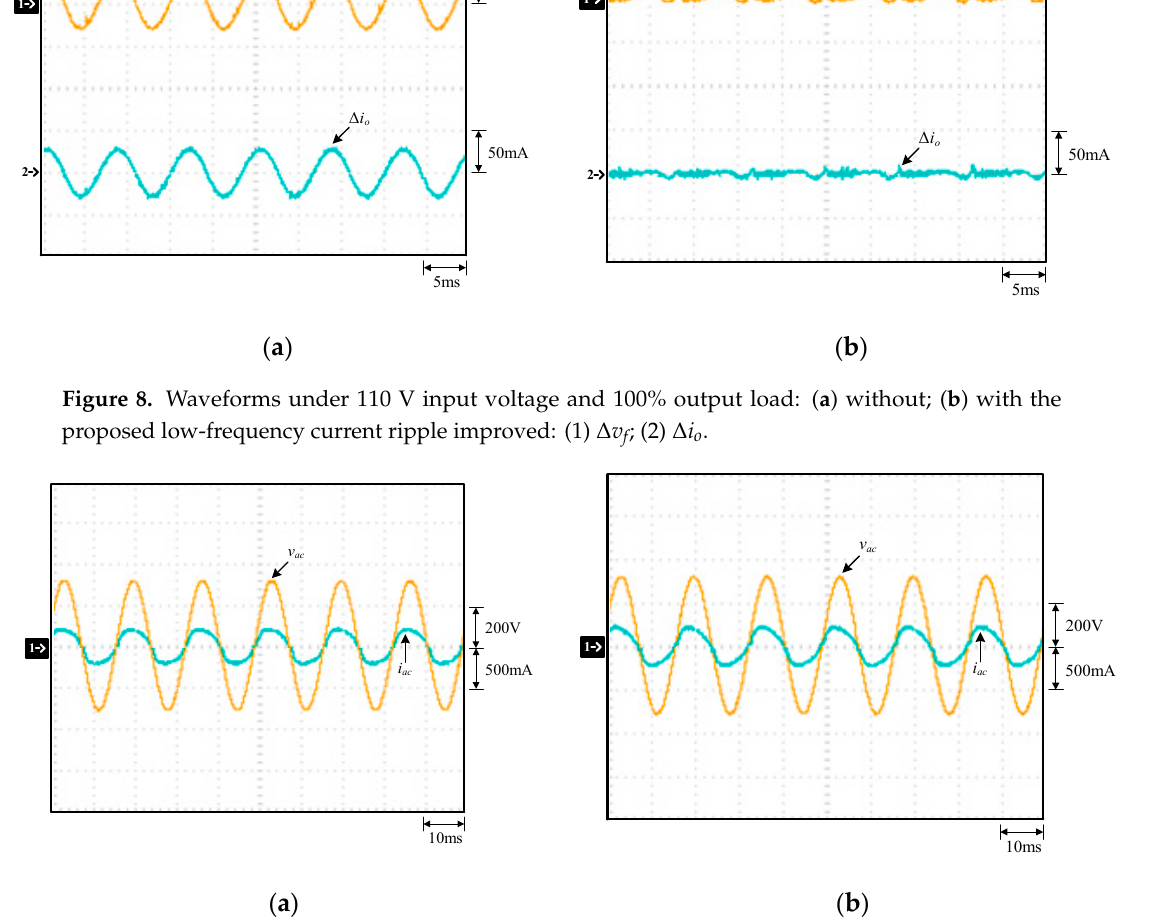
Figure 9. Waveforms under 220 V input voltage and 100% output load: ( a ) without; ( b ) with the proposed low-frequency current ripple improved: (1) v ac ; (2) i ac .